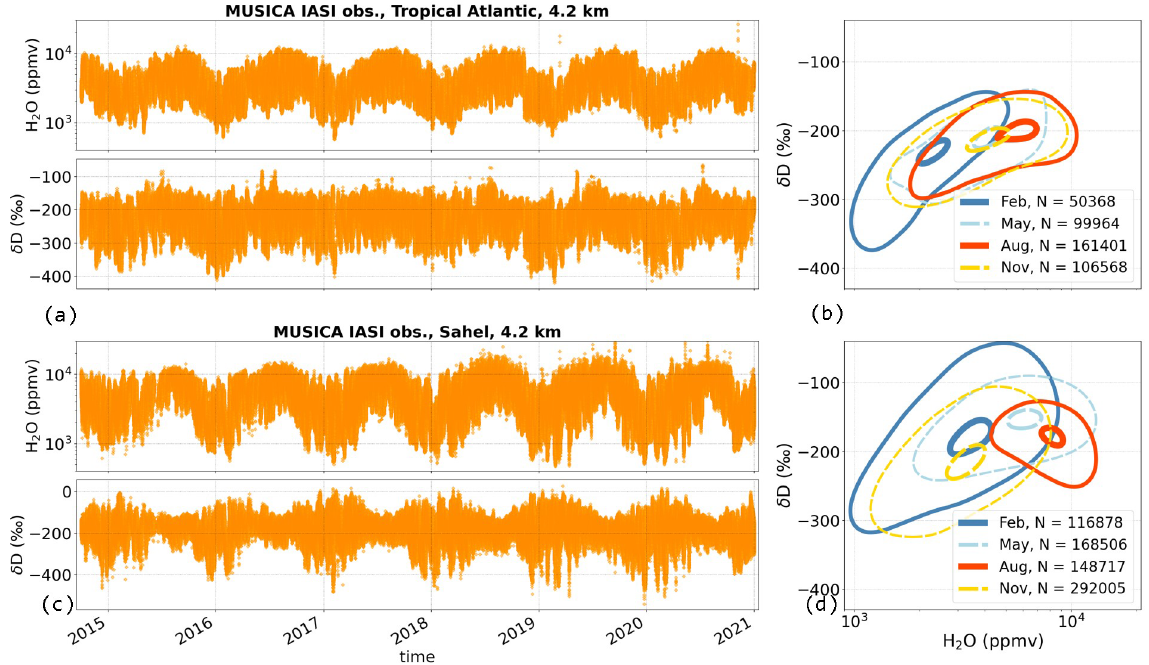
Figure 13. MUSICA IASI {H 2 O, δ D} pair data for 4.2kma . s . l . over the tropical Atlantic (13–17 ◦ N, 46–30 ◦ W) and the Sahel in West Africa (13–17 ◦ N, 8 ◦ W–8 ◦ E), for the full MUSICA IASI period. Panels (a) and (c) show the time series of H 2 O and δ D. Panels (b) and (d) show the respective probability density functions of the two-dimensional {H 2 O, δ D} distributions, indicating the location of the main 10% and 90% scatter points. These contours are drawn for the data of February, May, August and November, summarized for all respective